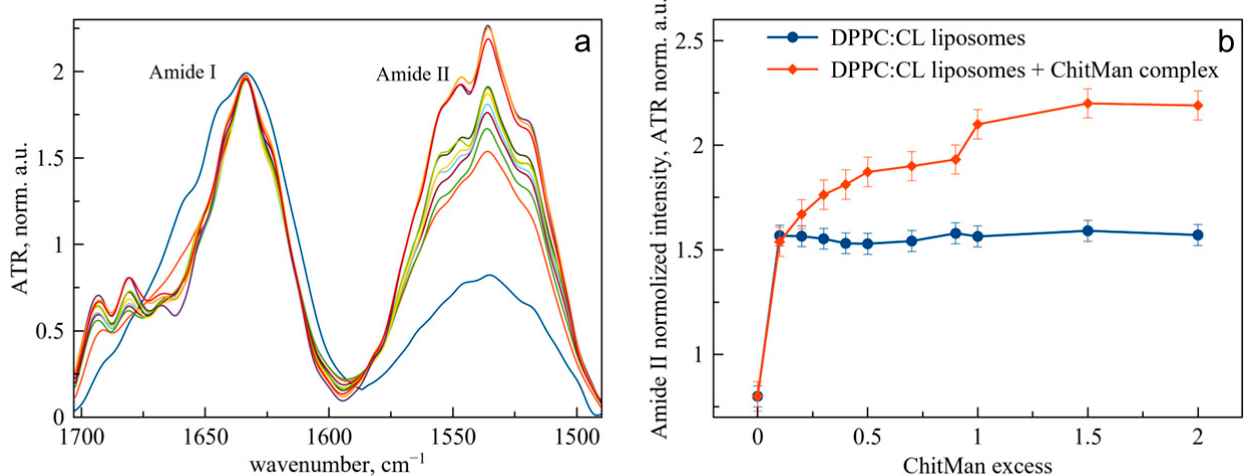
Figure 6. ( a ) Normalized ATR-FTIR spectra of ConA (blue) and in the presence of the complex of DPPC:CL 80:20 (weight %) liposomes with ChitMan (BME 5) in the amide I and II area. ( b ) Sorption isotherms of the complex DPPC:CL 80:20 (weight %) liposomes with ChitMan (BME 5). SD, n = 3. 0.02 M Na-phosphate buffer solution, pH 7.4, 22 ° С . ConA concentration 5.4 mg/mL. The concentration of the Ca 2+ and Mn 2+ ions is 3.6 × 10 − 5 M.